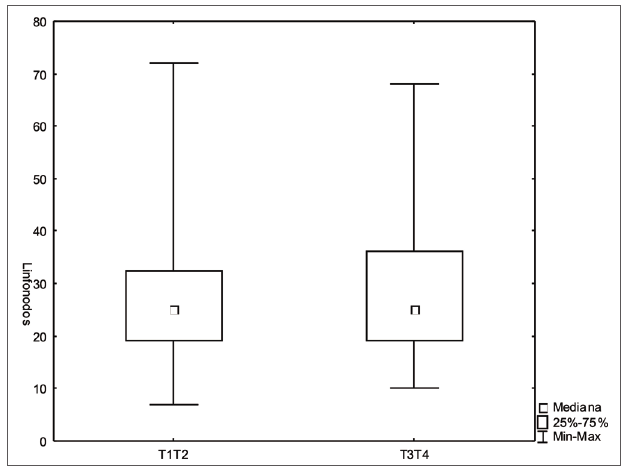
Figura 1. Número de linfonodos de acordo com o estádio T ( p